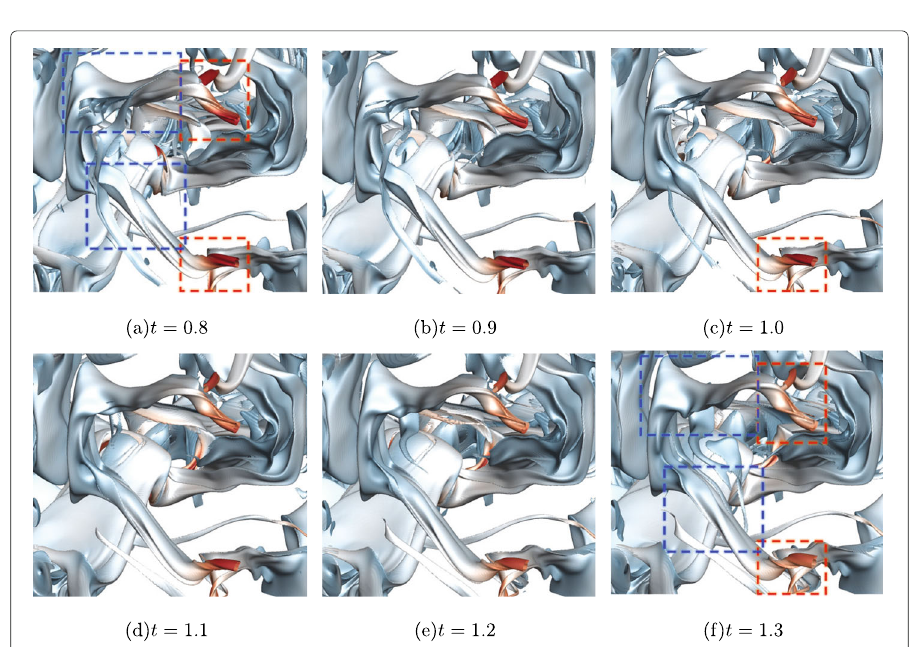
Fig. 10 Close-up view of the evolution of the VSF isosurface with V φ = V (cid:5) / 16 in the region marked by the black box in Fig. 9b in case M1 ( η M = 0.05). The color bar is the same as that in Fig.